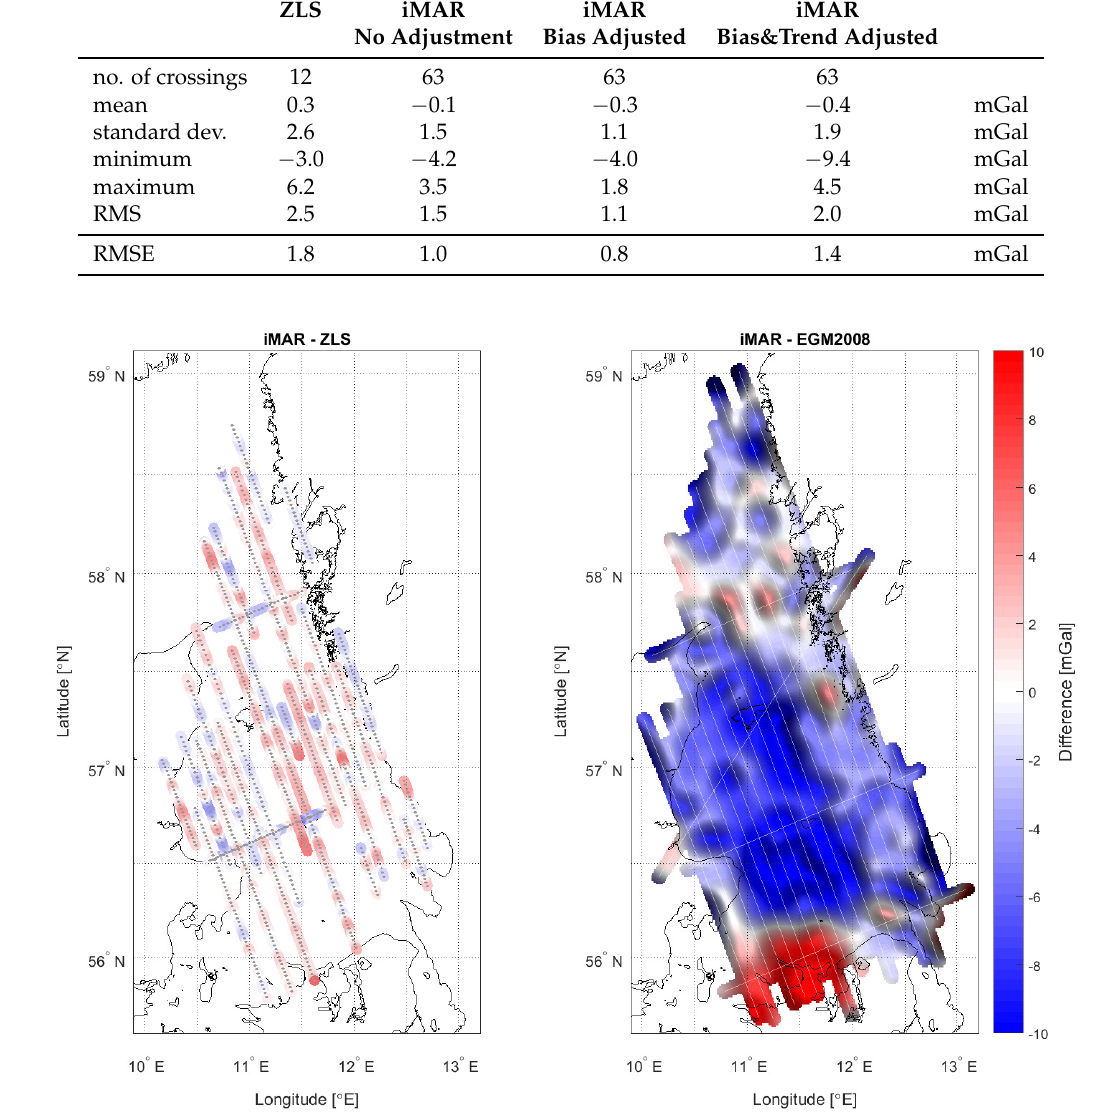
Figure 6. Difference between iMAR strapdown gravity estimates and other estimates. (Left): Difference between non-adjusted iMAR and ZLS estimates; (Right): Difference between bias adjusted iMAR estimates and EGM2008 global gravity